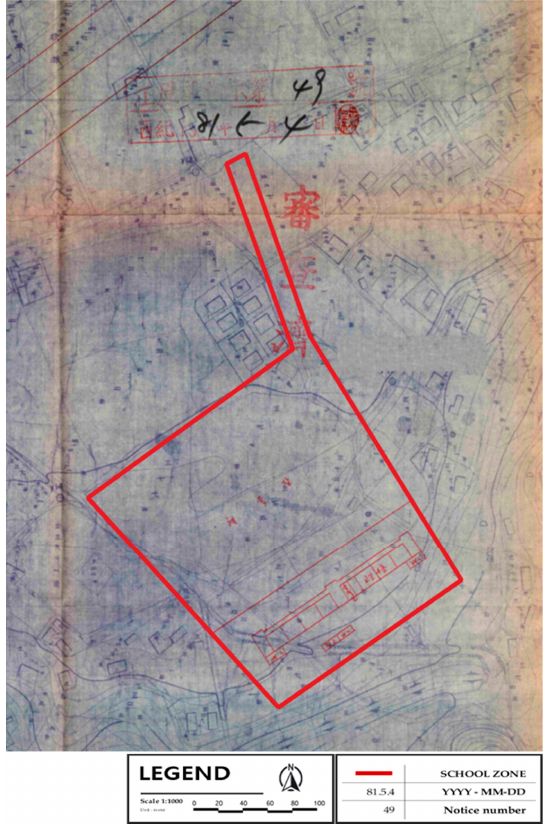
Figure 2. Drawing of the UPOCM. Source: Gangwon-do Office of Education [68].